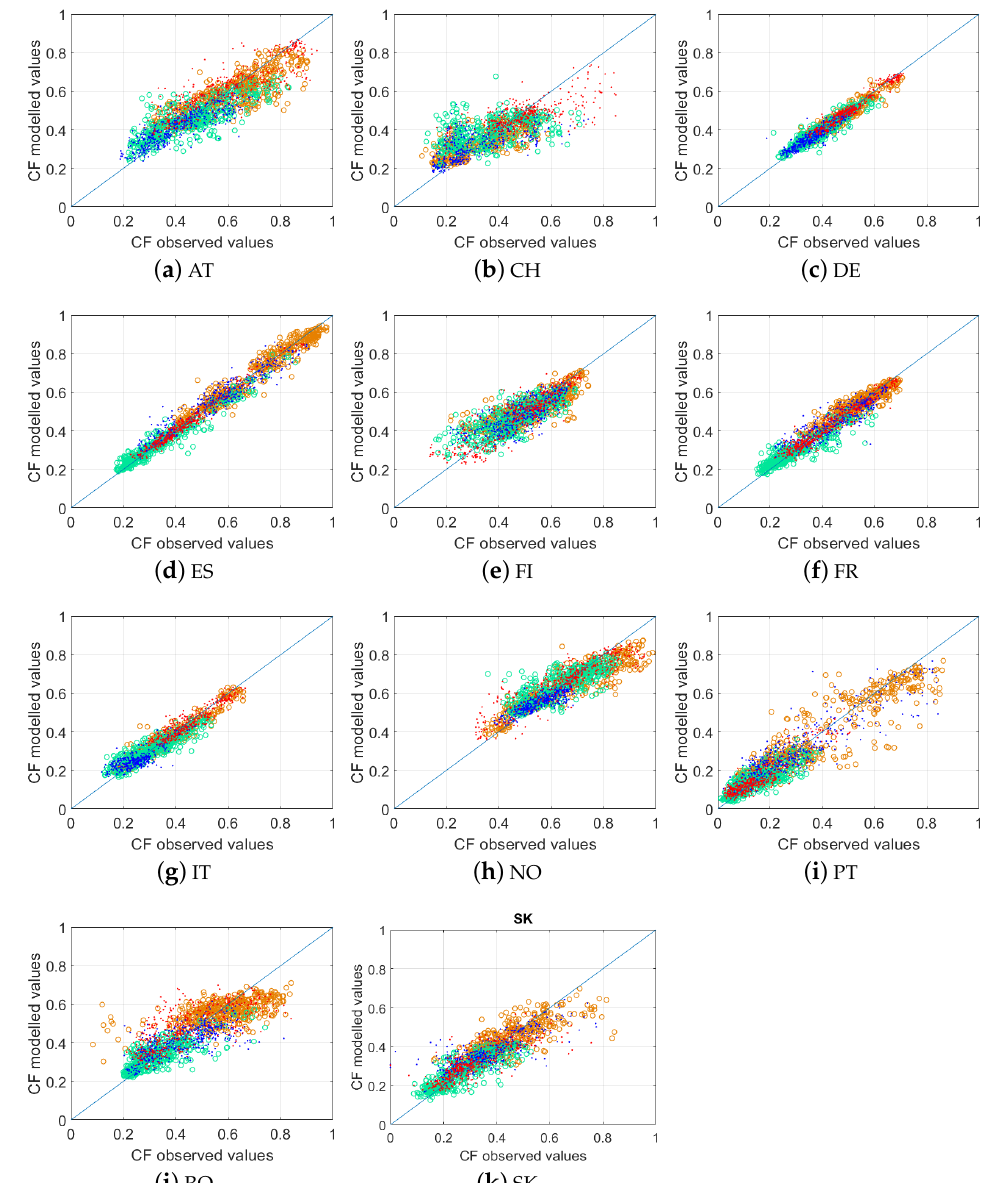
Figure 5. Scatter plot of the modeled and observed capacity factors. We indicate with blue dots the values in the period December–January–February (DJF), with orange circles the values in the period March–April–May (MAM), with red dots for June–July–August (JJA) and, finally, with green circles for September–October–November